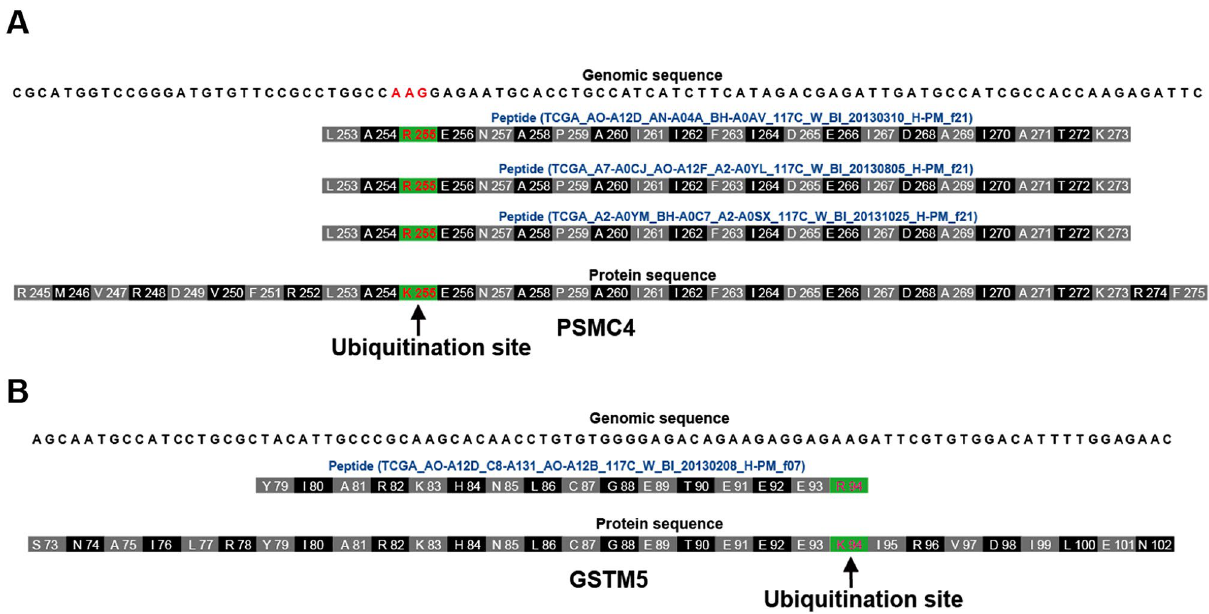
Figure 4. The edited ubiquitination sites by nonsynonymous RNA editing were identified from CPTAC database. ( A , B ) Peptides and its genomic location on the human genome. The genome view was snapshotted from UCSC genome browser with slightly modification. The ubiquitination site was highlighted in red and green background. The peptides sequences harboring AAs altered by nonsynonymous RNA editing were highlighted in blue. The altered AAs were also highlighted in red and green background. Genomic sequence was located on the top of each